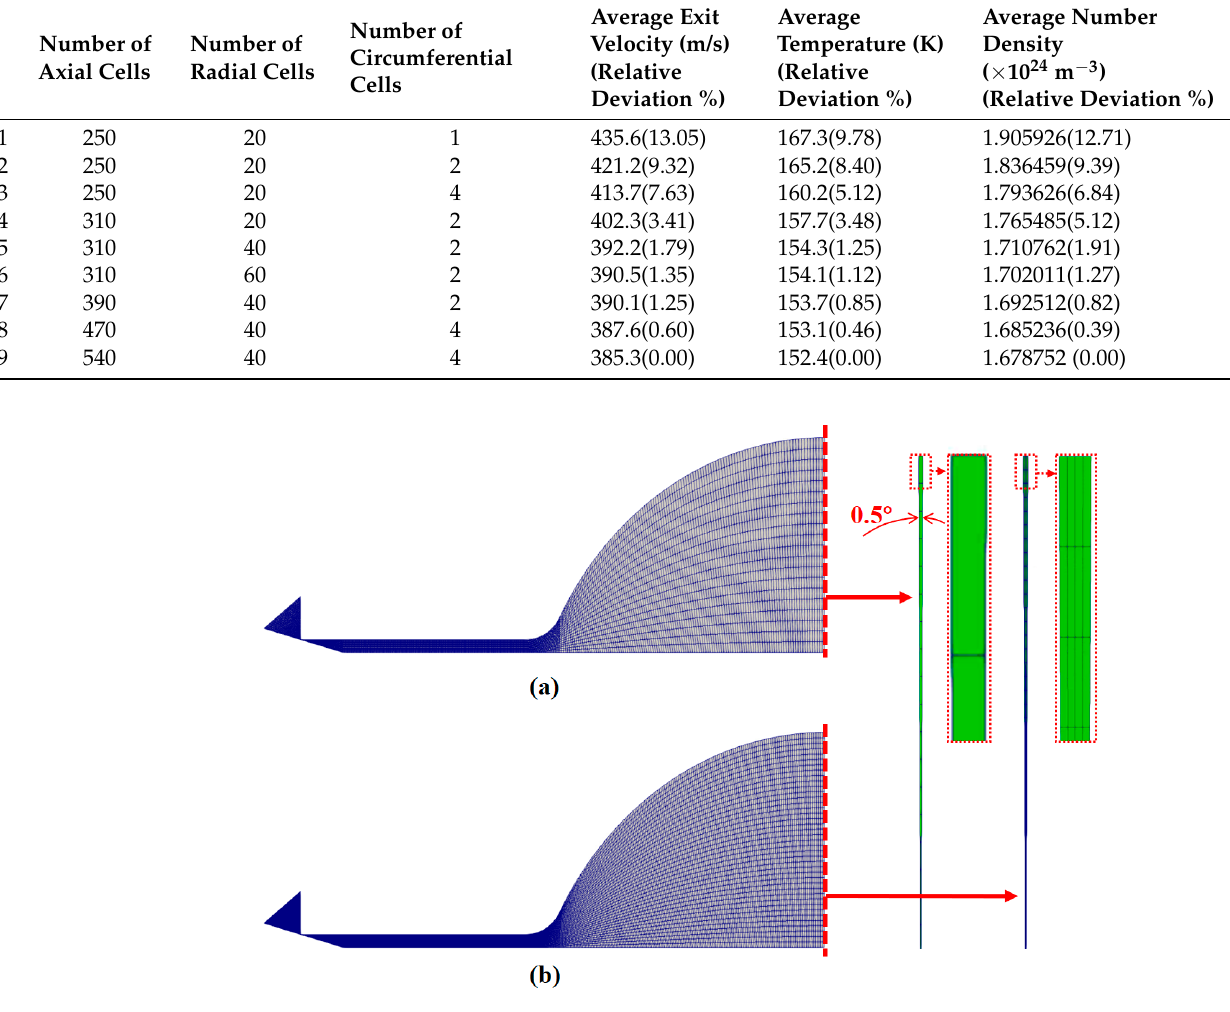
Figure 5. Comparison of ( a ) Cells 1 and ( b ) Cells 9.